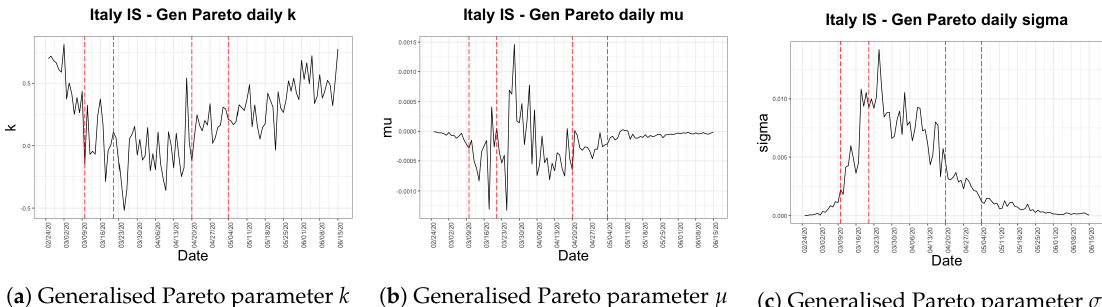
Figure 6. Time series for Italy infection speed generalised Pareto parameters. Spain